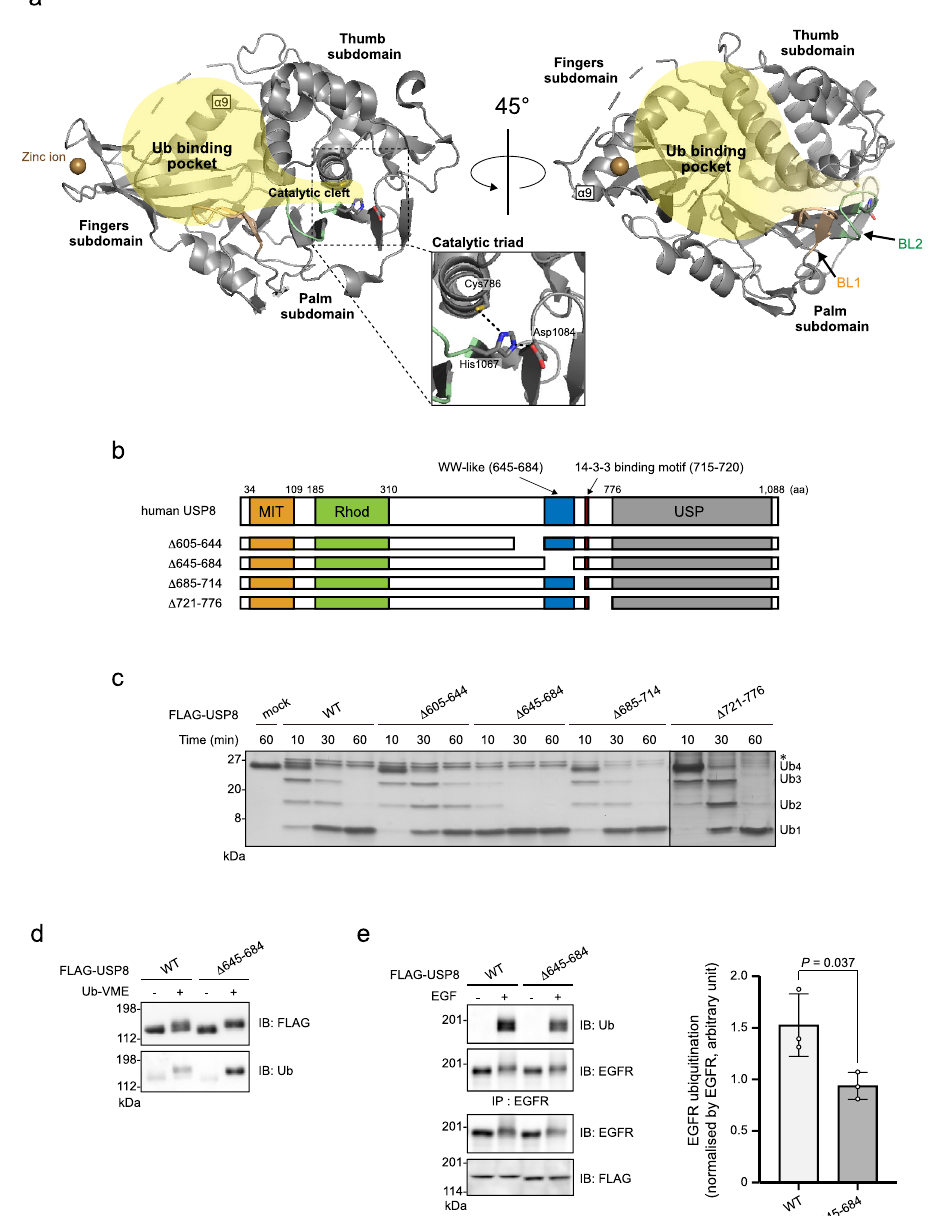
Fig. 1 Effects of the deletion of amino acids (aa) 645 – 684 on USP8 activity. a Crystal structure of the USP domain (aa 762 – 1109; PDB ID: 2GFO). Two representations are rotated by 45° around the Y-axis. The fi ngers, palm and thumb subdomains are indicated. The catalytic triad formed by Cys 786 , His 1067 and Asp 1084 is shown in the enlarged view. The ubiquitin-binding pocket and catalytic cleft are indicated in yellow. The upper-left broken loop between Asp 888 and Asn 898 is non-structural. BL1, blocking loop 1; BL2, blocking loop 2. b Schematic structures of human USP8 and the truncated mutants used in c : MIT, MIT domain; Rhod, rhodanese-like domain; WW-like, WW-like domain identi fi ed in this study; USP, USP domain. c Deubiquitination activities of the USP8 mutants. HEK293T cells expressing FLAG-tagged USP8 mutants were lysed. Anti-FLAG immunoprecipitates were subjected to an in vitro deubiquitination assay using a Lys63-linked ubiquitin tetramer and then to SDS-PAGE and silver staining. *, copuri fi ed protein (s) with USP8. d Ubiquitin- vinyl methyl ester (Ub-VME)-labelling of USP8 Δ 645 – 684 . Immunoprecipitated USP8 (WT or Δ 645 – 684) were labelled and subjected to immunoblotting (IB). e EGFR ubiquitination levels in cells expressing USP8 Δ 645 – 684 . HeLa cells stably expressing USP8 (WT or Δ 645 – 684) were treated with EGF or left untreated. The lysates were subjected to immunoprecipitation (IP) and IB. The right graph shows EGFR ubiquitination levels normalised by EGFR in the immunoprecipitates (means ± standard deviations of three independent experiments). Statistical signi fi cance was determined using Student ’ s t -test. See Supplementary Fig. 1.